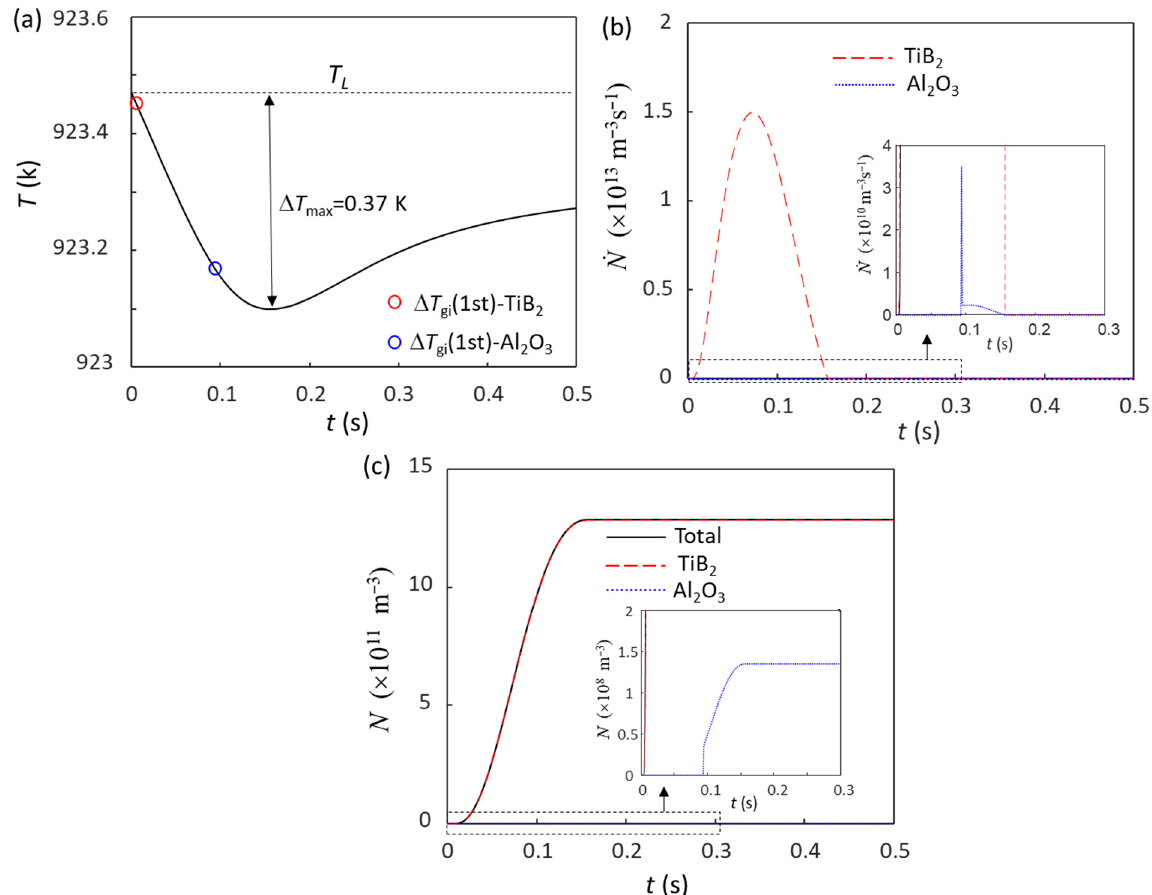
Figure 3. Solidification behavior of Al-4Cu alloy at Ṫ = 3.5 K/s with the addition of 0.1 wt.% Al-5Ti- 1B grain refiner. ( a ) Cooling curve; ( b ) grain initiation rate; ( c ) initiated grain number density. The red and blue dots in ( a ) mark the onset of grain initiation on solid particles induced by TiB 2 and Al 2 O 3 particles, respectively.